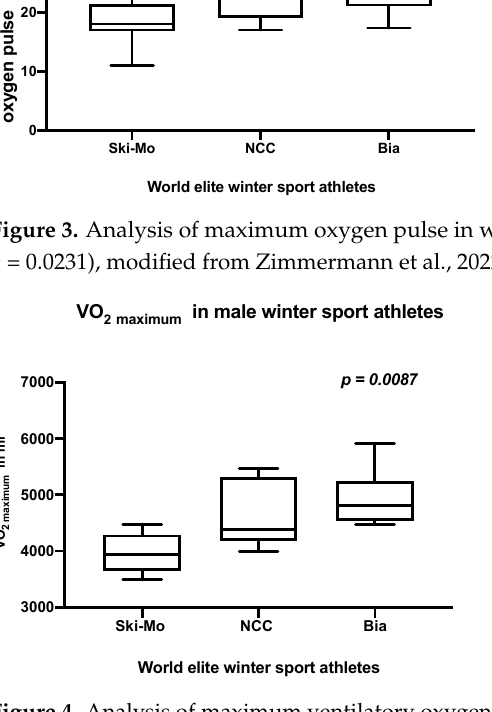
Figure 3. Analysis of maximum oxygen pulse in world elite winter sport professionals ( p = 0.0033, p = 0.0231), modified from Zimmermann et al. 2022 [22].